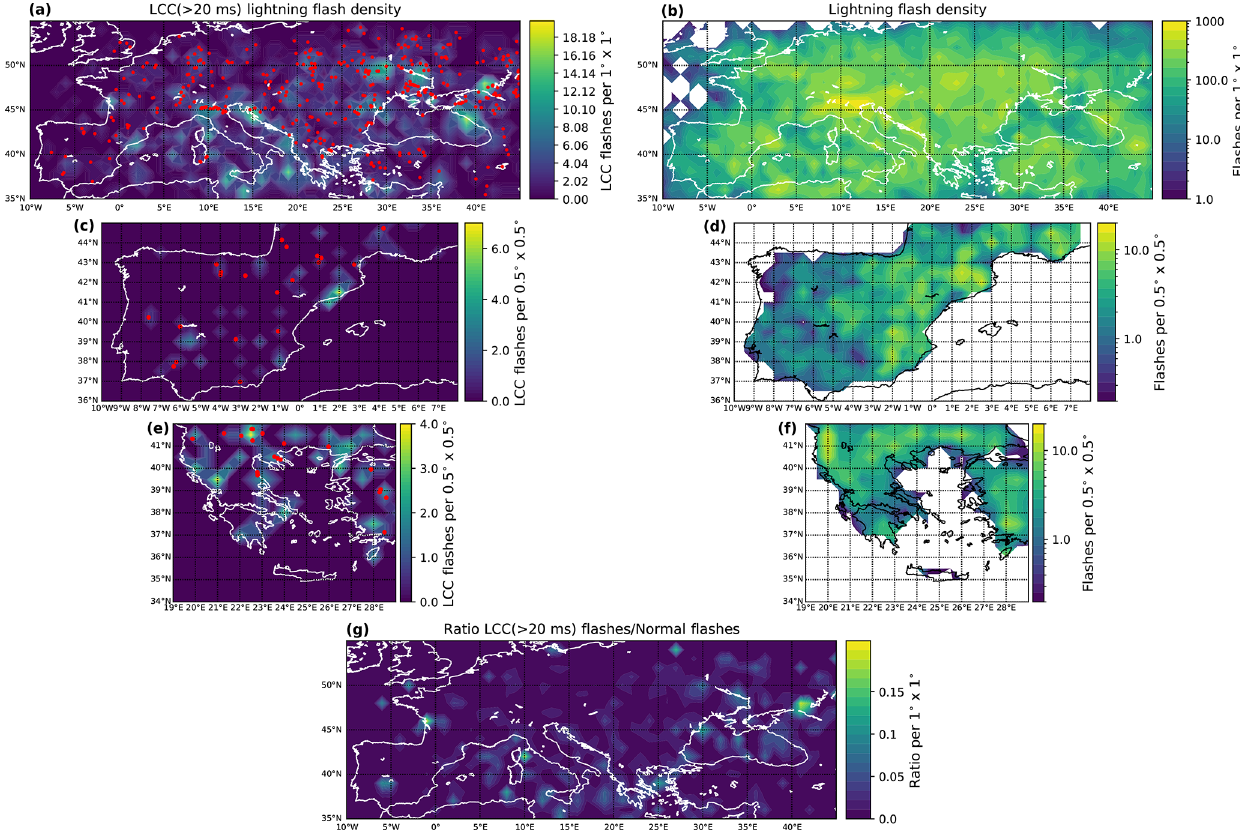
Figure 15. LCC( > 20ms) lightning flash density (a, c, e) , total lightning flash density (b, d, f) , and the ratio between them (g) from ISS-LIS lightning measurements between March 2017 and September 2020. Panels (a, b) show maps over Europe with 1 ◦ × 1 ◦ , while panels (c, d) and (e, f) show magnified views of the regions of interest (only flashes over land) in a 0 . 5 ◦ × 0 . 5 ◦ cell. Red dots in the left row represent the LCC( > 20ms) lightning flashes taking place over land and with CBH larger than 2000m. For the sake of clarity, in the map of Europe (g) , the ratio in one cell is set to zero if there are fewer than 10 lightning flashes and fewer than 2 LCC( > 20ms) lightning